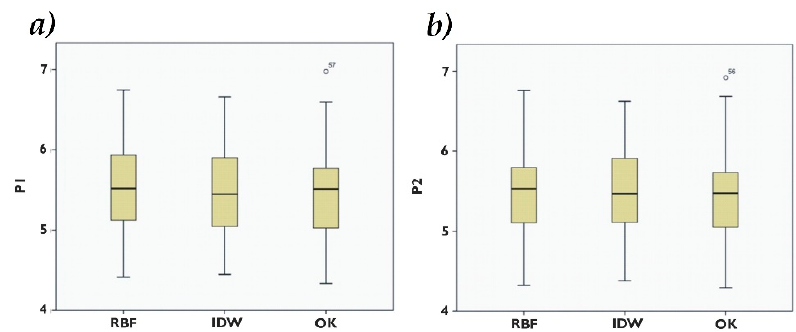
Figure 7. Box diagram for values of P1 ( a ) P2 ( b ). IDW = inverse distance weight, OK = ordinary kriging, RBF = radial basis function, P1 = Test 1, P2 = Test Table 4. Accuracy of interpolation methods IDW, OK, and RBF.